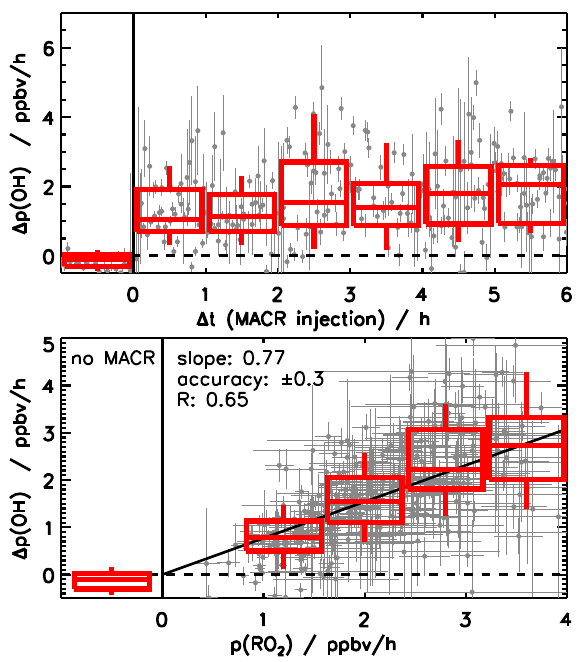
Figure 3. Scatter plot of the missing OH source ( 1p( OH ) ) and (1) the time that has elapsed since the first MACR injection (upper panel) and (2) production of RO 2 from the reaction of MACR and OH (lower panel). Grey dots give individual data points with statis- tical errors for all three experiments (Table 1); boxes show 25 and 75% percentiles and whiskers 10 and 90% percentiles. The value of the linear correlation coefficient of R = 0 . 65 shows the good cor- relation between the RO 2 production from MACR and the missing OH source. The slope of a weighted linear fit (black line) suggests that on average 0.77 OH radicals are recycled from RO 2 for condi- tions of these experiments. The error of 0.3 is calculated from the accuracy of